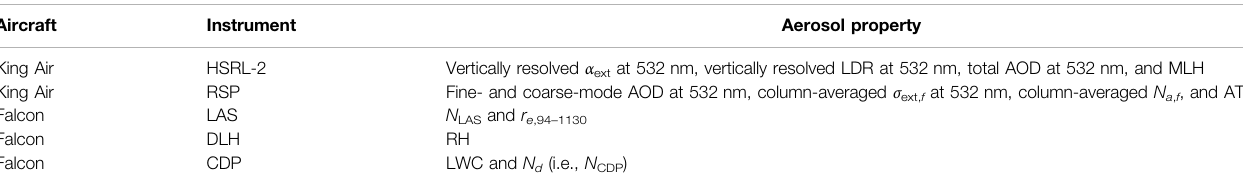
TABLE 2 | List of measurement products used in this study, which are grouped by the both the instrument each measurement was derived from and the ACTIVATE aircraft each instrument was mounted on.